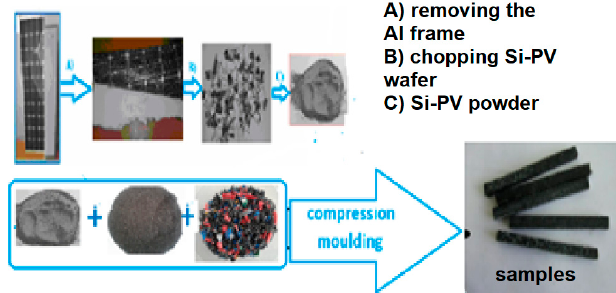
Figure 1. Preparing the waste silicon photovoltaic (Si-PV) powder from PV module and all waste hybrid composites.